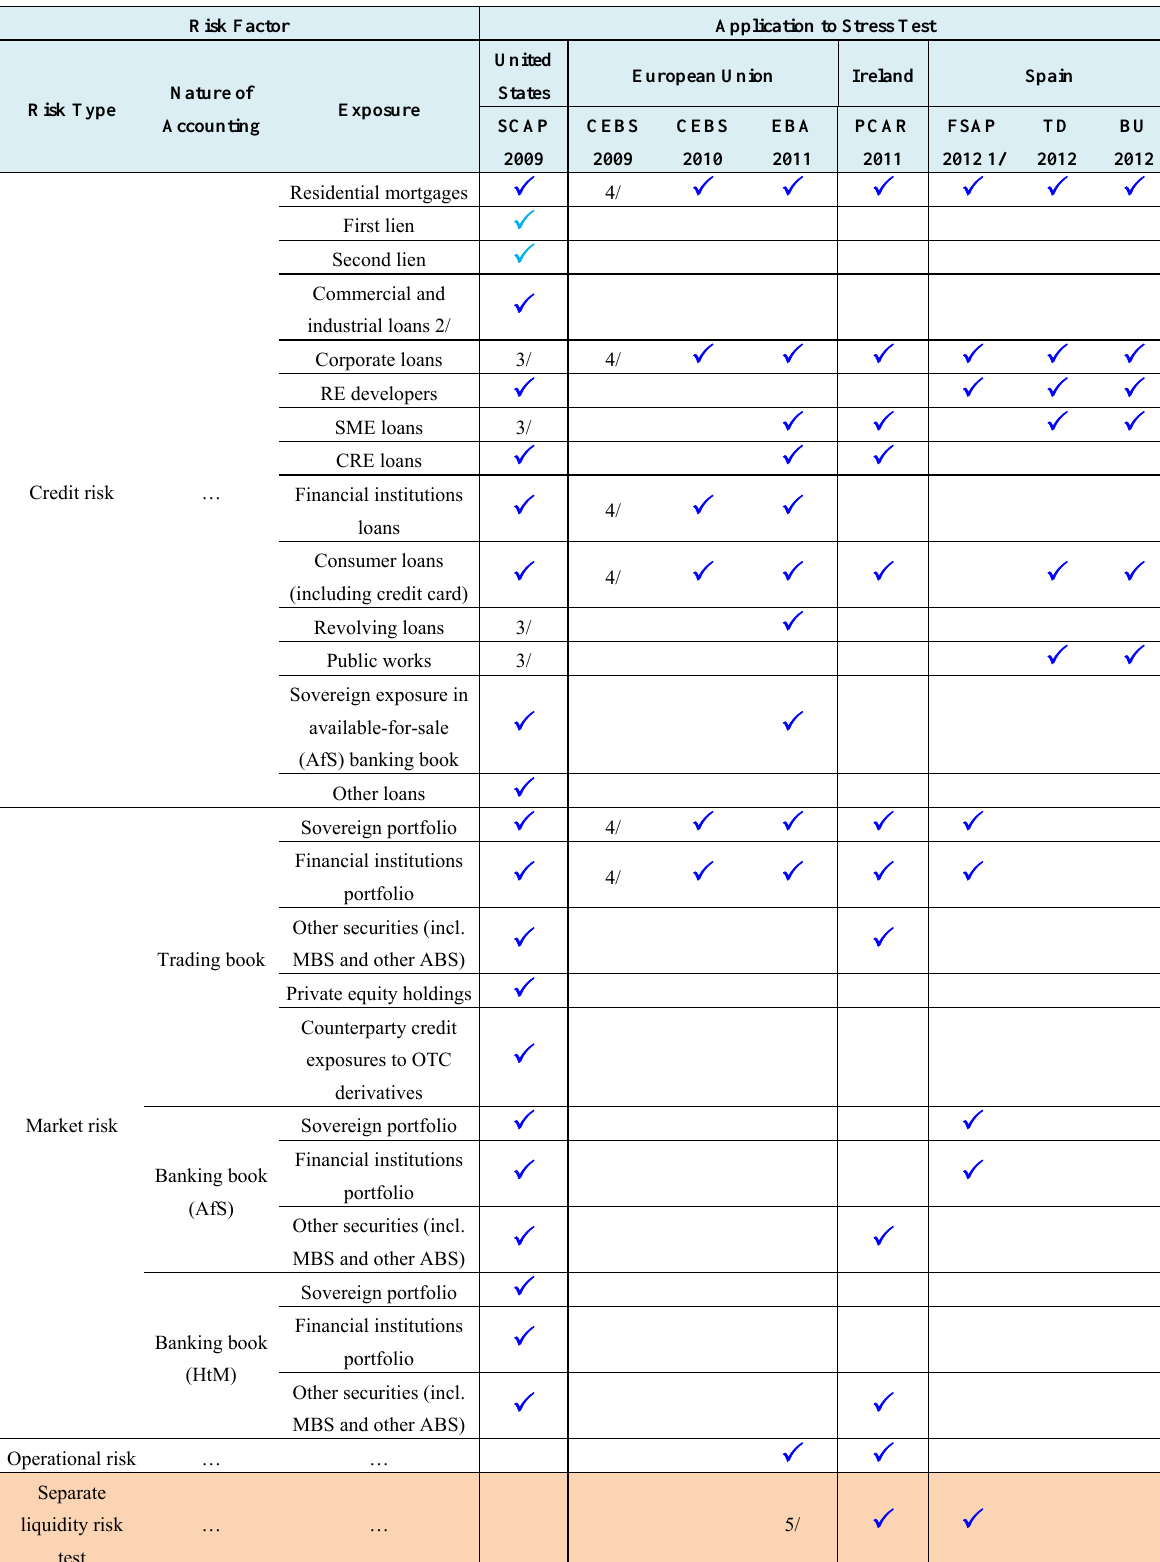
Table 8. Crisis Stress Tests: Risk Factors